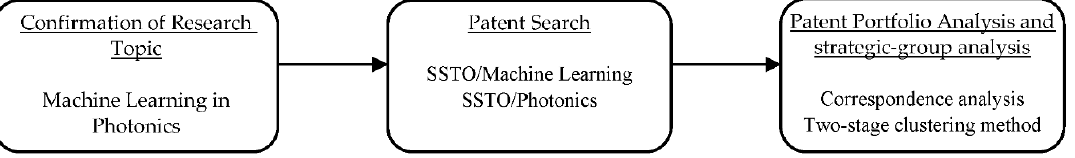
Figure 1. Analysis of patent portfolio of machine learning in photonics.